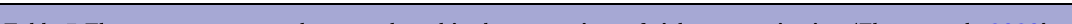
Table 5 The message-cantered approach and its best practices of risk communication (Zhang et al., 2020).